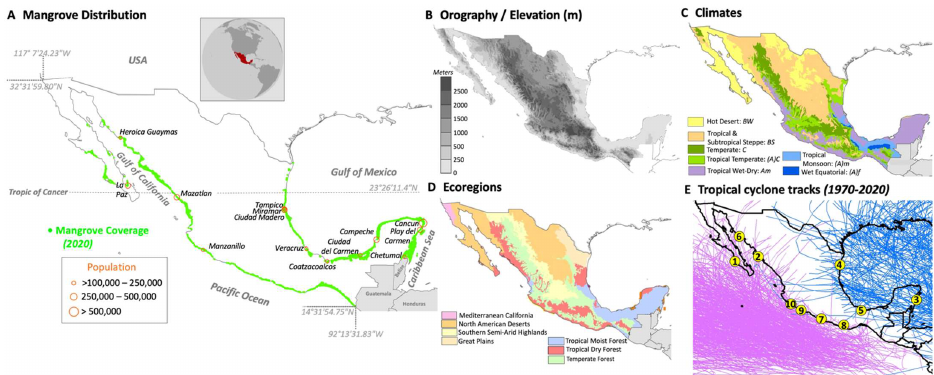
Figure 1. ( A ) Mangrove wetland distribution [95] and coastal populations centers (>100,000) in Mexico [96]; ( B ) orography and relative elevation (m) [97]; ( C ) climate classification regions [98]; ( D ) Ecoregions [99]; ( E ) tropical cyclones’ trajectory and density in the Atlantic (blue color) and Pacific basins (pink color). The top ten landing sites are shown in decreasing order per state: 1: Baja California, 2: Sinaloa, 3: Quintana Roo; 4: Tamaulipas; 5: Veracruz; 6: Sonora; 7: Guerrero; 8: Oaxaca; 9: Michoac á n; 10: Colima